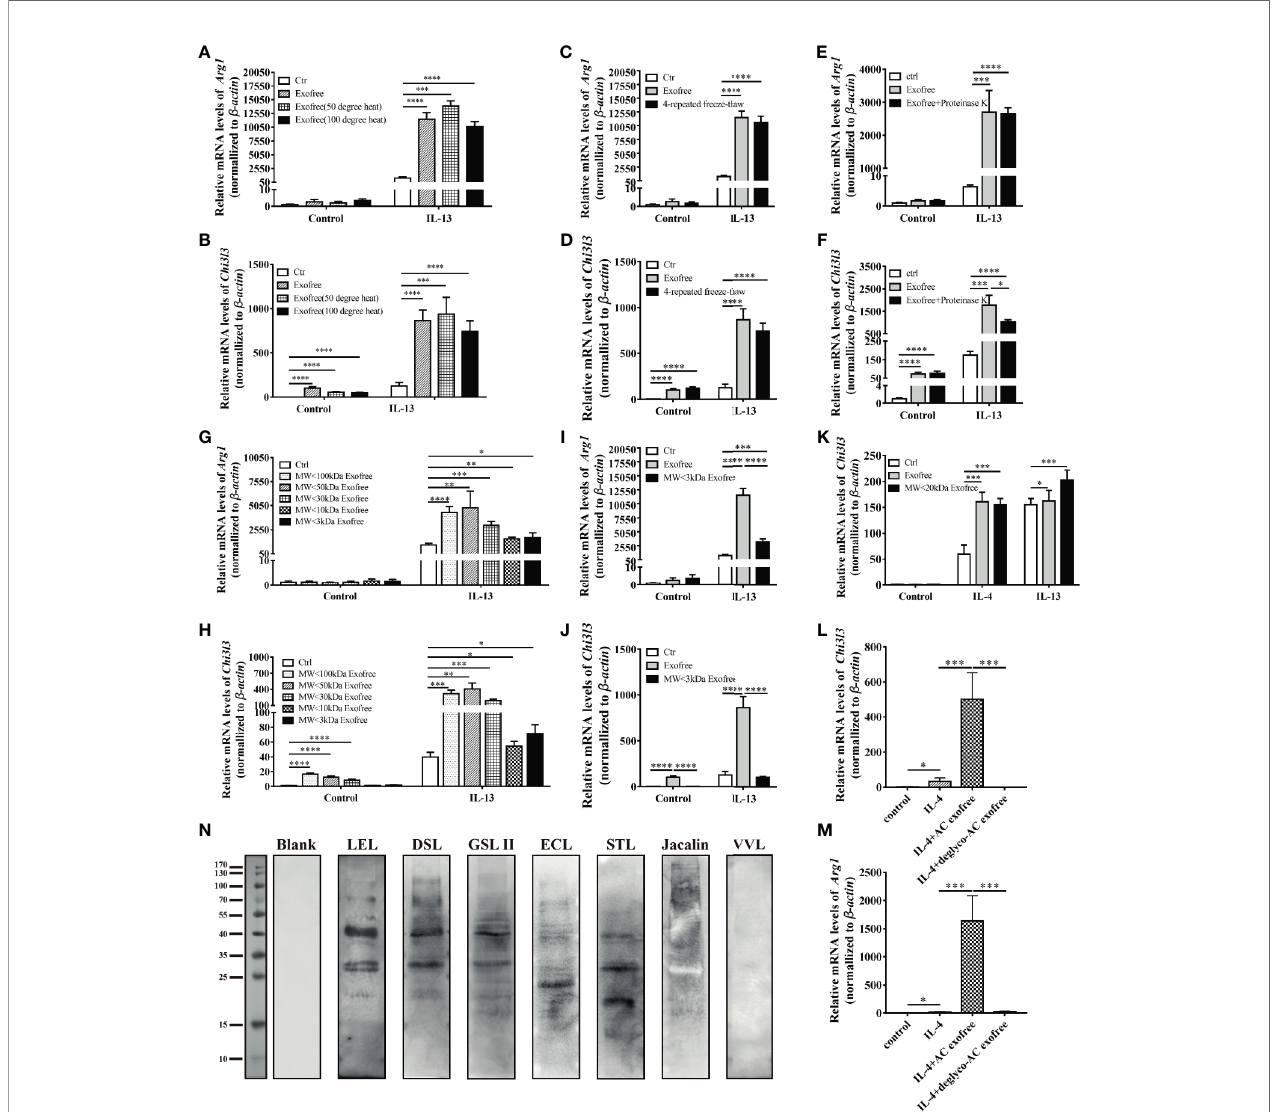
FIGURE 5 | Chemical and physical property analysis of AC L4 exofree suggested glycoproteins as the key components in AC L4 exofree – induced M2 polarization of macrophage. (A, B) qPCR analysis of Arg1 (A), Chi3l3 (B) mRNA level of BMDMs in the presence of PBS, AC L4 exofree, AC L4 exofree (50°C water bath, 15min), AC L4 exofree (100°C water bath, 15min), IL-13, AC L4 exofree+IL-13, AC L4 exofree (50°C water bath, 15min)+IL-13, AC L4 exofree (100°C water bath, 15 min)+IL-13 at 24 h was performed. (C, D) qPCR analysis of Arg1 (C) , Chi3l3 (D) mRNA level of BMDMs in the presence of PBS, AC L4 exofree, AC L4 exofree (repeated freeze-thaw cycles for four times) at 24 h was performed. (E, F) qPCR analysis of Arg1 (E) , Chi3l3 (F) mRNA level of BMDMs in the presence of PBS, AC L4 exofree, AC L4 exofree (100 m g/ml proteinase K treatment: 58°C water bath, 2 h; proteinase K inactivation: 100°C water bath, 15 min) at 24 h was performed. (G, H) qPCR analysis of Arg1 (G) , Chi3l3 (H) mRNA level of BMDMs in the presence of PBS, AC L4 exofree, AC L4 exofree (<3 kDa fraction), AC L4 exofree (<10 kDa fraction), AC L4 exofree (<30 kDa fraction), AC L4 exofree (<50 kDa fraction), AC L4 exofree (<100 kDa fraction), IL-13, AC L4 exofree+IL-13, AC L4 exofree (<3 kDa fraction)+IL-13, AC L4 exofree (<10 kDa fraction)+IL-13, AC L4 exofree (<30 kDa fraction)+IL-13, AC L4 exofree (<50 kDa fraction)+IL-13, AC L4 exofree (<100 kDa fraction)+IL-13, at 24 h was performed. (I, J) qPCR analysis of Arg1 (I) and Chi3l3 (J) mRNA level of BMDMs in the presence of PBS, AC L4 exofree, AC L4 exofree (<3 kDa fraction), IL-13, AC L4 exofree+IL-13, AC L4 exofree (<3 kDa fraction)+IL-13 at 24 h was performed. In (A – J) , the concentration of exofree is 440 m g/ml and the concentration of IL-13 is 10 ng/ ml. (K) qPCR analysis of Chi3l3 mRNA level of BMDMs in the presence of PBS, AC L4 exofree, AC L4 exofree (<20 kDa fraction), IL-13, AC L4 exofree+IL-13, AC L4 exofree (<20 kDa fraction)+IL-13 at 24 h was performed. In (K) , the concentration of exofree is 44 m g/ml, the concentration of IL-13 is 10 ng/ml. (L, M) Control (PBS) or AC L4 exofree or deglycosylated AC L4 exofree were used to stimulate BMDMs. And mRNA expression level of Chi3l3 (L) and Arg1 (M) were measured 24 h after the stimulation using qPCR. (N) Glycoproteins in AC L4 exofree were measured by lectin blot. Membranes were incubated with PBS (lane Blank), lectin LEL, DSL, GSL II, ECL, STL, Jacalin, and VVL as primary antibody, respectively. The same amount of exofree is used in experiments from (A – M) . Data information: *P <0.05, **P <0.01, ***P <0.001, ****P